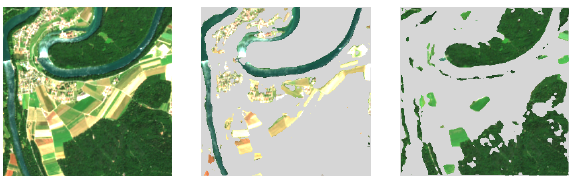
Figure 1. Sample satellite image with two derived concepts that semantically describe water and man-made structures on the one hand and forests on the other